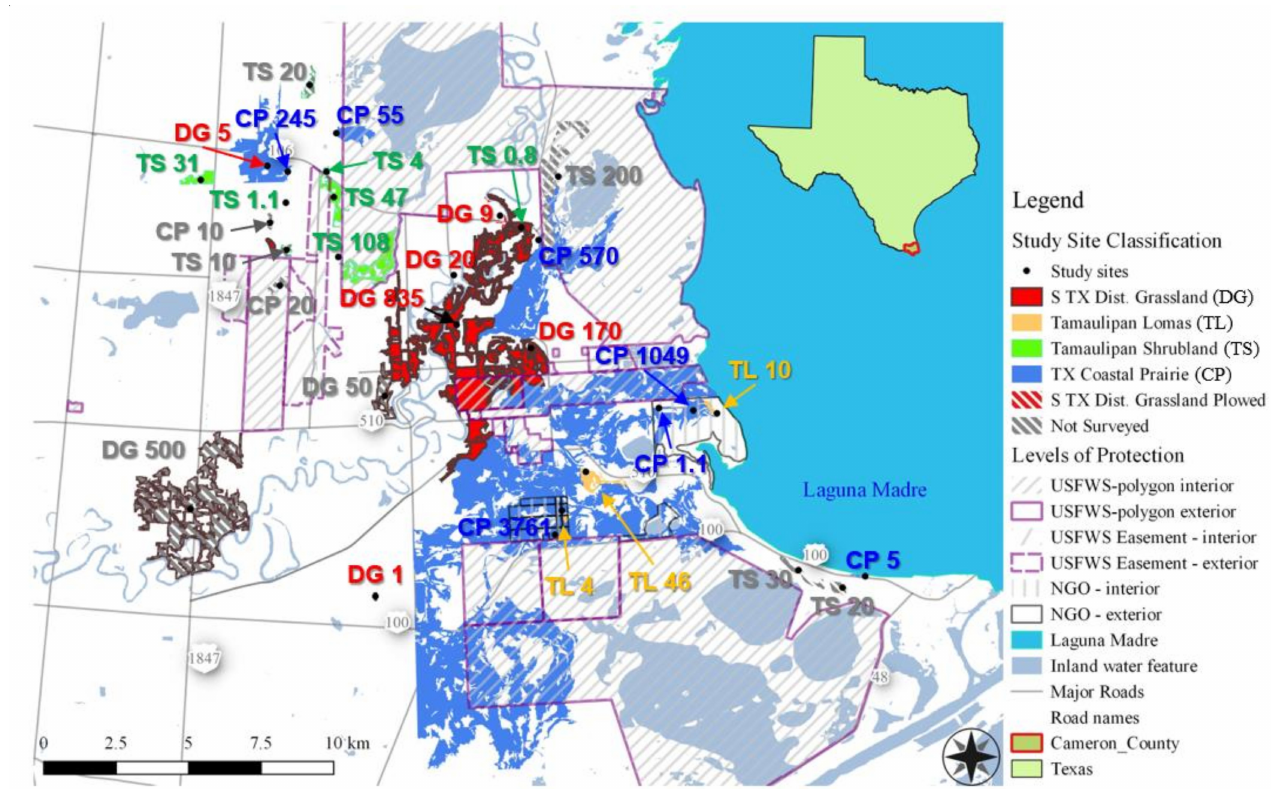
Figure 1. Study sites used for this investigation. Colored polygons represent the spatial extent of habitat patches of different geospatial classes. See Methods for classification details. Numbers after the 2-letter site classification codes denote patch size in ha. Also shown are polygons with different hashing to represent relevant land ownership categories (USFWS, private with a USFWS conservation easement, and conservation-oriented NGO), which confer different levels of habitat protection and permit different types of land use. Land not bounded by a hashed protection polygon is privately owned without any conservation